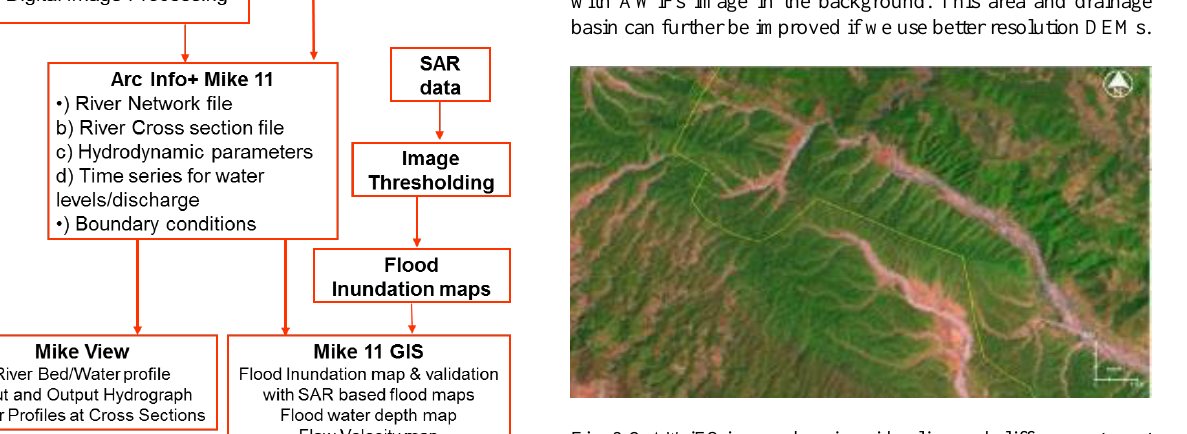
Fig. 3.2. AWiFS image showing ridge line and cliff, correct w.r.t